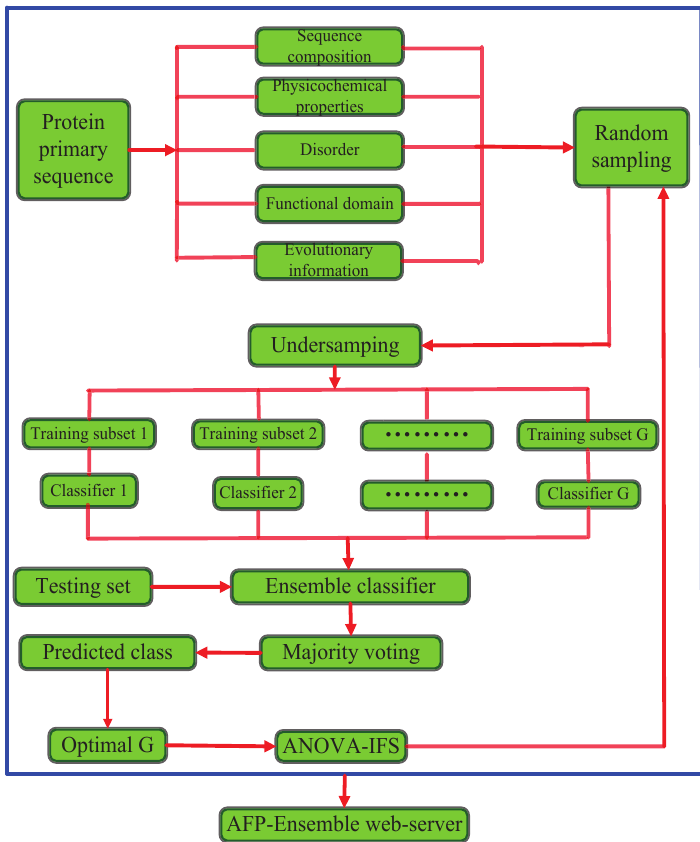
Figure 1. The system architecture of the proposed method. ANOVA-IFS: Analysis of variance with incremental feature